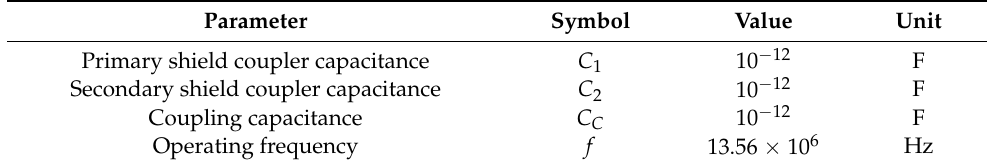
Table 1. Circuit parameters for ratio analysis.